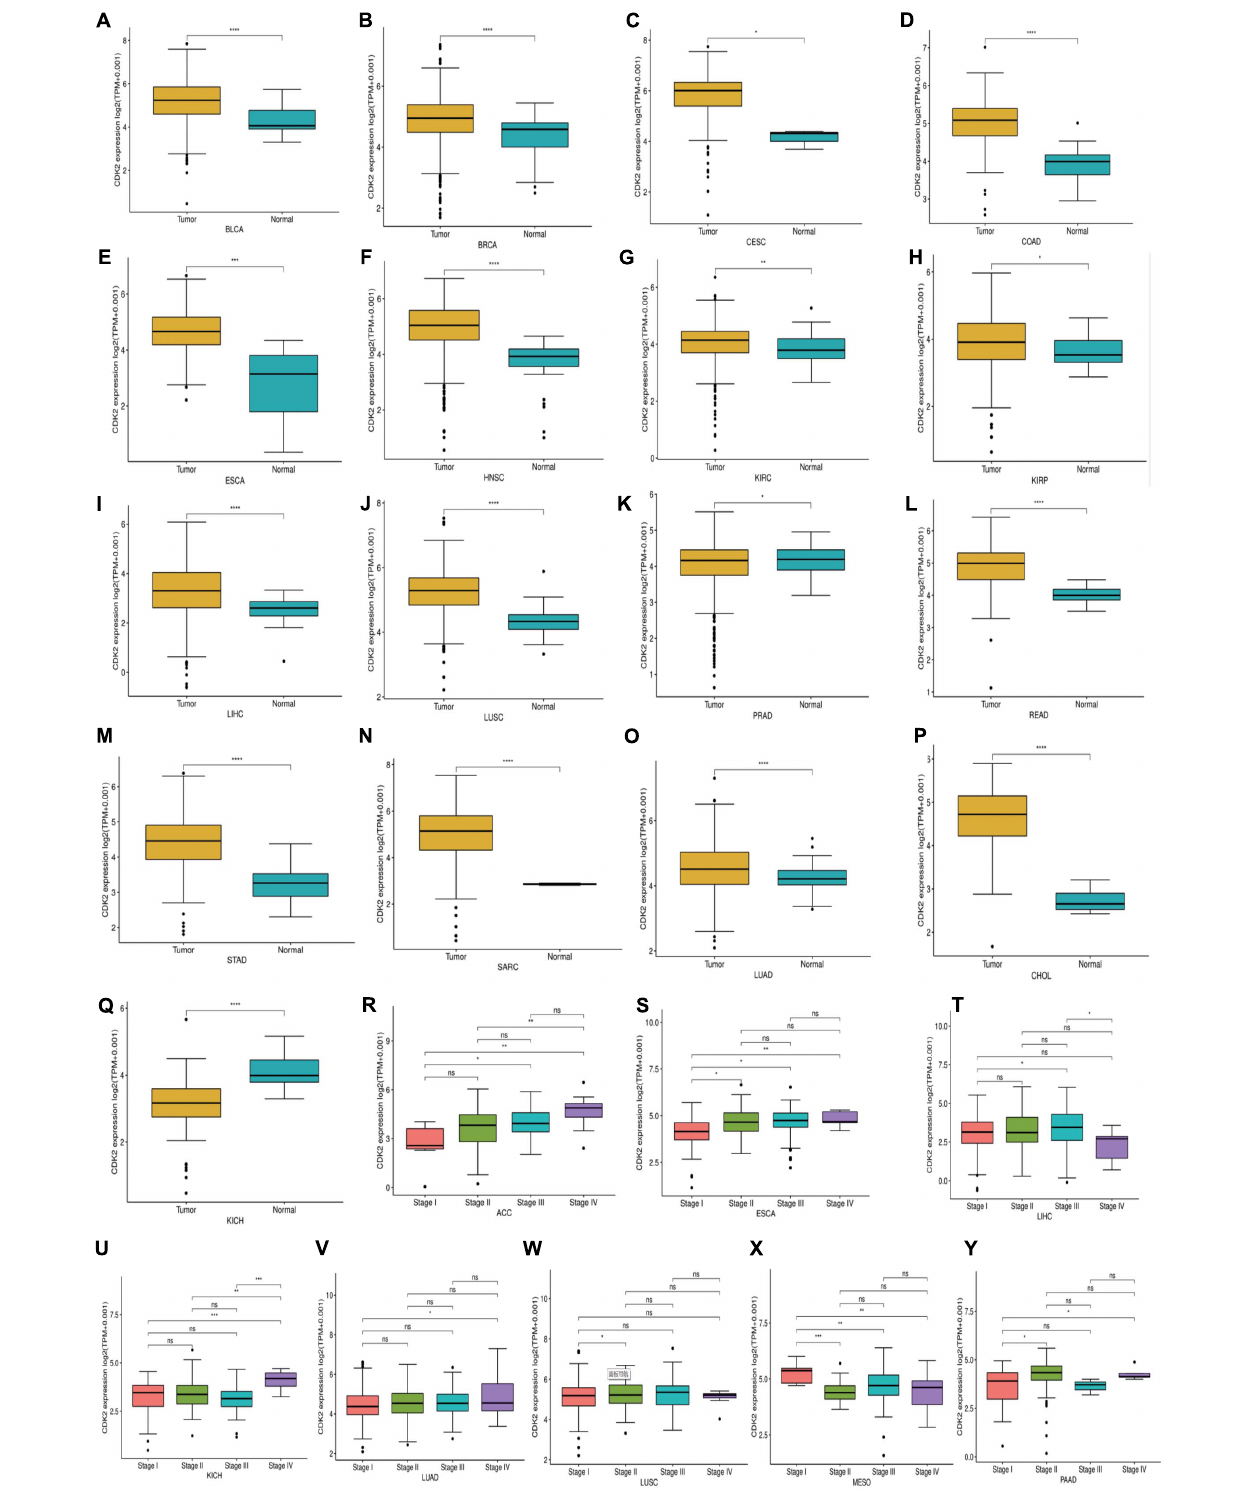
FIGURE 6 | The expression and stage of different cancer. (A–Q) The expression of CDK2 was relatively high in 17 cancers. (R–Y) The different expression levels of CDK2 had statistical significance on the stage of patients. (* P < 0.05, ** P < 0.01, *** P < 0.001, **** P < 0.0001).